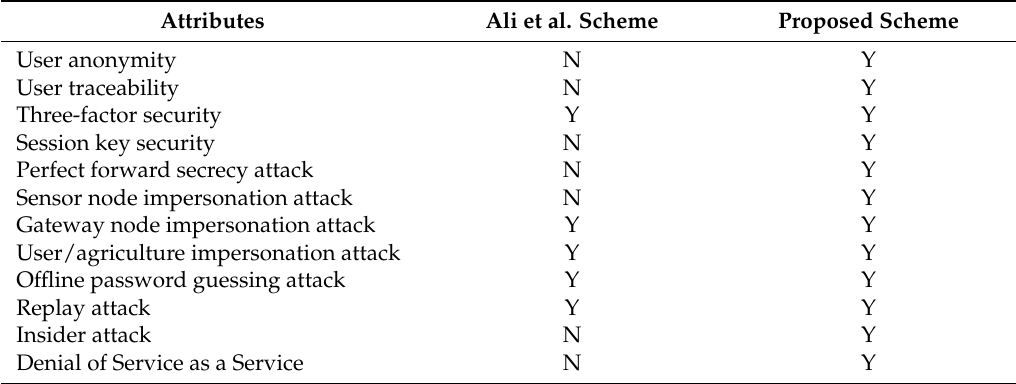
Table 3. Functionality